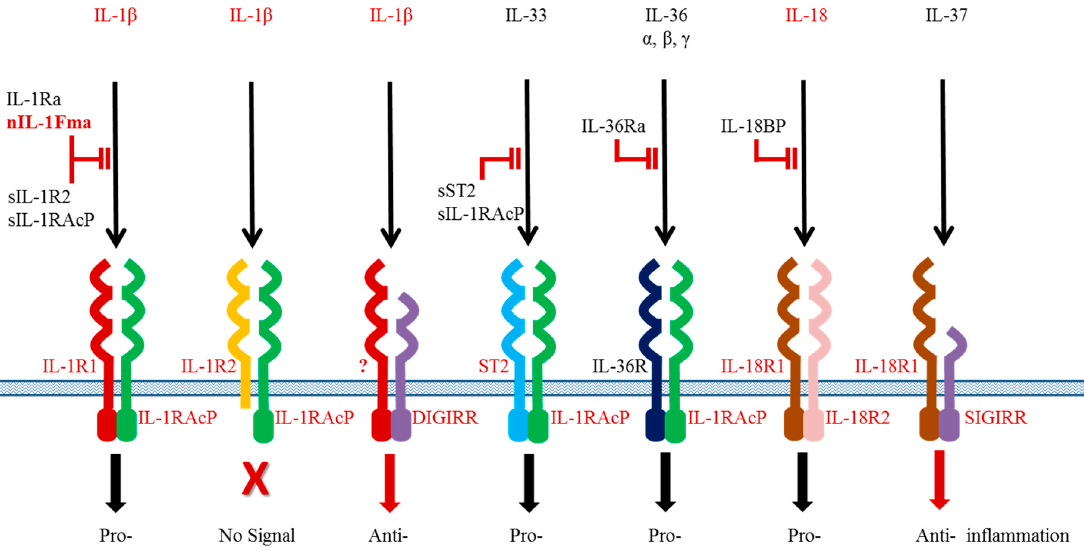
Figure 1. Interaction of the IL-1 family cytokines and receptors. The homologues identified in fish are indicated in red.